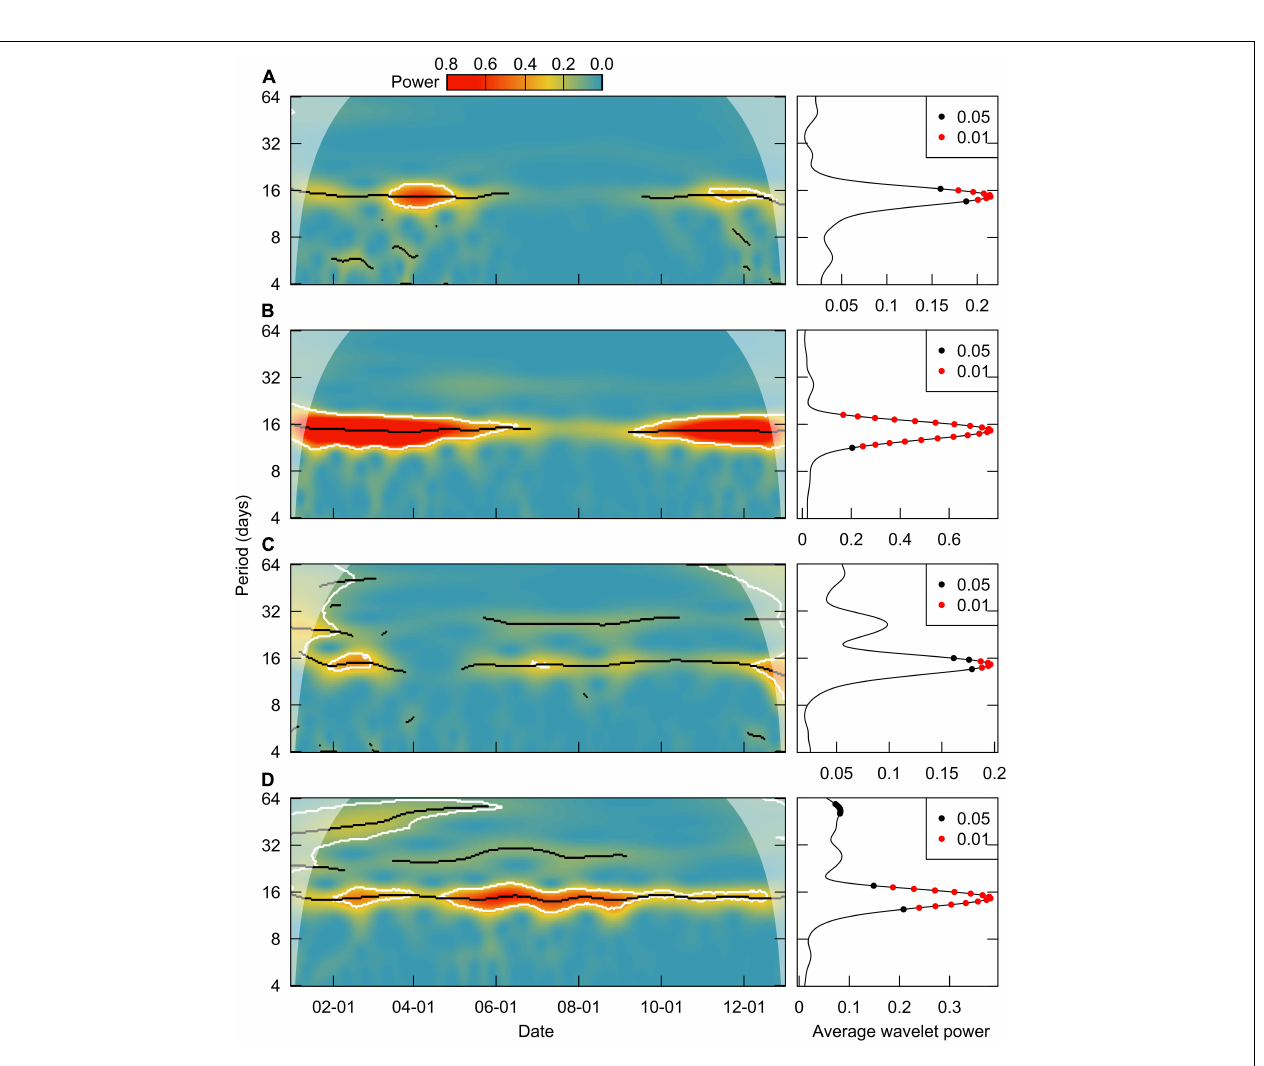
FIGURE 4 | Wavelet power spectrum and significance level for Chl- a in four typical areas (A–D) . The white and black lines represent a significance level of 0.05 and the power ridge, respectively. The significant level of the power spectrum circled by white lines is less than 0.05, and power ridge indicates the local maximization of power spectrum. Black and red dots in the right panels denote the significance level of 0.05 and 0.01 for average wavelet